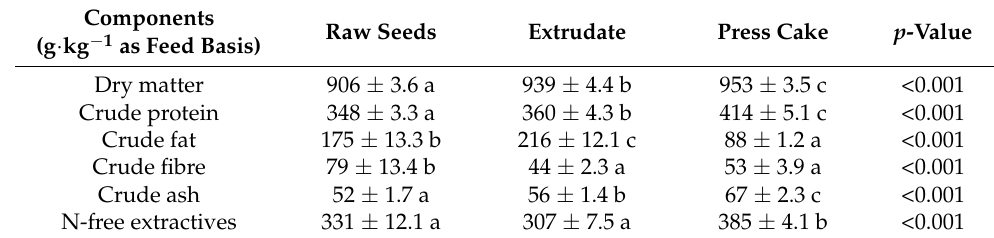
Table 6. The content of basic nutrients in the raw soybean seeds and feed products (the mean values from 3 soybean varieties ± SD).